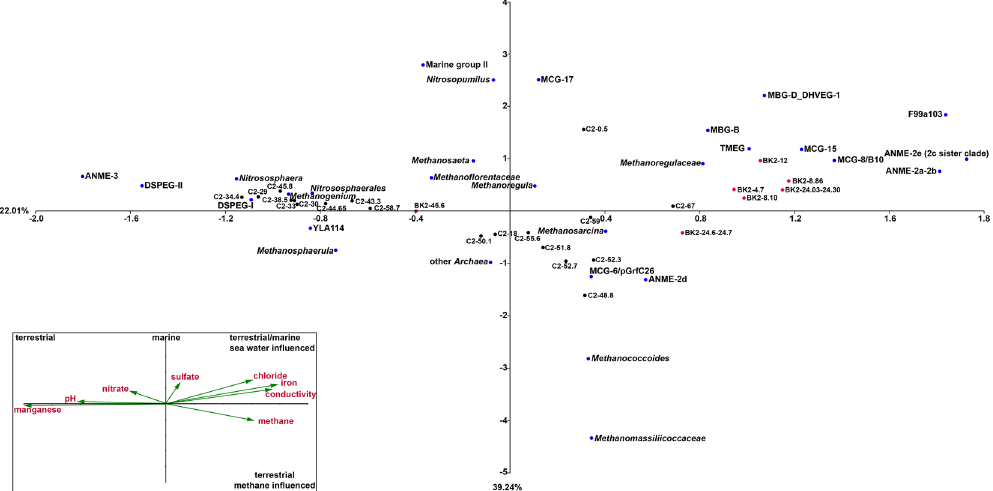
Figure 5. Canonical correspondence analysis (CCA) of environmental factors and archaeal taxa that contributed with more than 1% in any of the depth. Inlet: Environmental factors are plotted as triplot with scaling 3. Samples of core C2 are projected as black dots and samples of BK2 as red dots. The archaeal taxa are shown as blue dots. Percentages at axes represent the ‘Eigenvalues’ that explain the variability for the first two